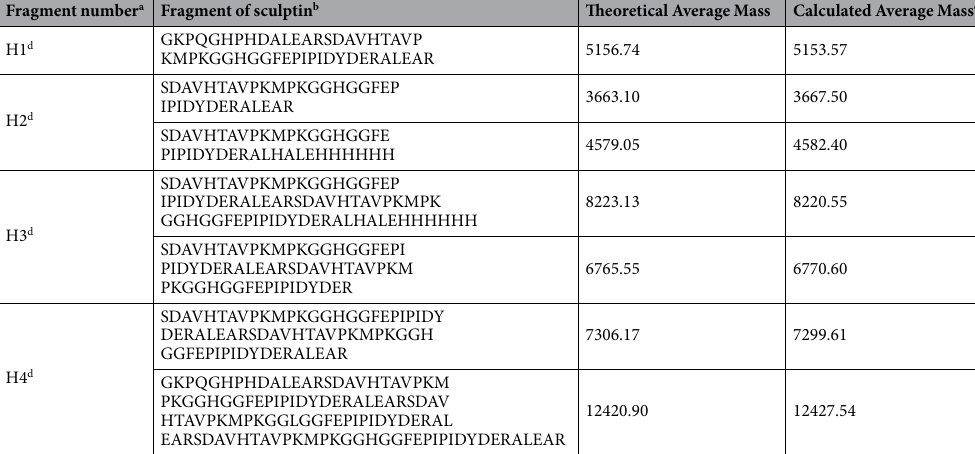
Table 1. The fragments of sculptin generated by factor Xa. Sculptin (10 µ M) was incubated without or with 1 µ M of factor Xa in 50 mM phosphate buffer containing 150 mM NaCl and 50 µ M PS/PC, pH 7.4 for 6 h at 37 °C. The reaction mixtures were separated by reverse phase C-18 HPLC column. The peaks were subjected to MALDI-TOF MS. a Peak number of the HPLC chromatogram (Fig. 5A). b Fragment of sculptin generated by factor Xa. c The experimental average mass calculated by MALDI-TOF mass spectrometry (Fig. 5B). d The fractions (HPLC peaks) were subjected to thrombin inhibition test (Fig. 5C,D).